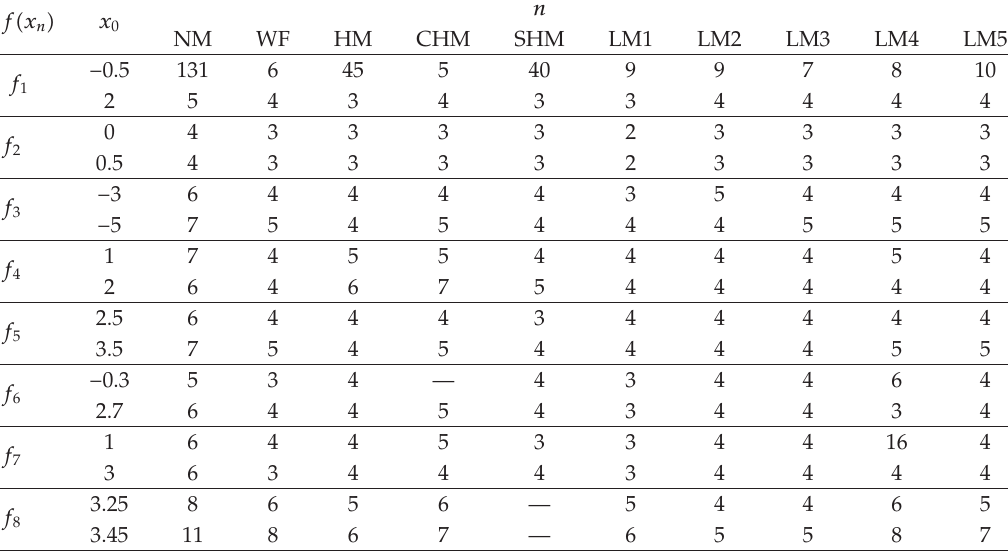
Table 1: Comparison of various third-order methods and newton’s method.